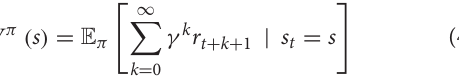
and obstacle center, respectively. The red circle is the threat zone and the gray zone is the motion permitted zone. d m